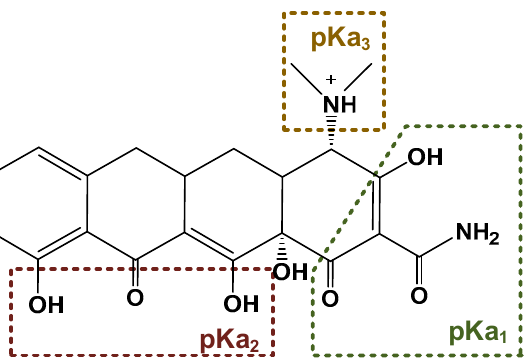
Figure 1. The backbone structure of the tetracycline family of antibiotics and its three pK a sites. The major compounds of the tetracycline family include tetracycline (TC), oxytetracycline (OXY), chlortetracycline (CTC), and doxycycline (DOXY). Their structure and pK a